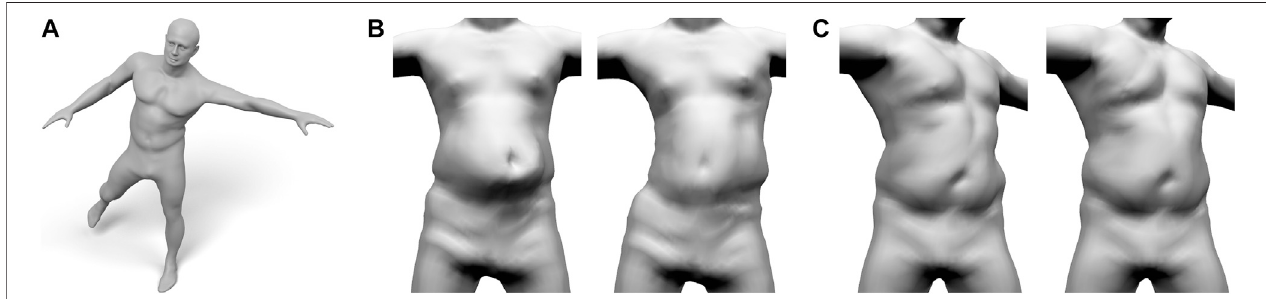
FIGURE12| Ourlayeredanatomical modelcanbeanimatedusing anextension ofFastProjective Skinning(FPS), asshown in (A) .Whenthecharacterperformsa jump tothe left (B) , ourrealistic skeleton correctly restrictsthe dynamic jigglingto thebelly region (B-Left) , while theoriginalFPSdeforms thecomplete torso (B-Right) . For a static twist of the torso (C) , the rib-cage of our layered model keeps the chest region rather rigid and concentrates the deformation to the belly (C-left) . Without a proper anatomical model, the deformation of FPS is distributed over the complete torso (C-right) .